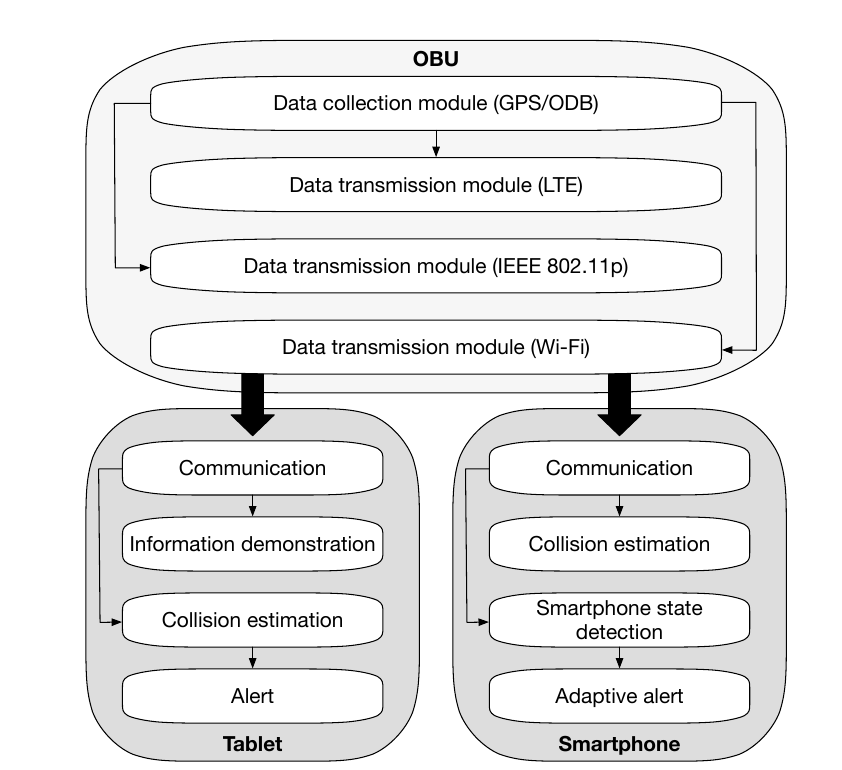
Figure 2. The proposed software